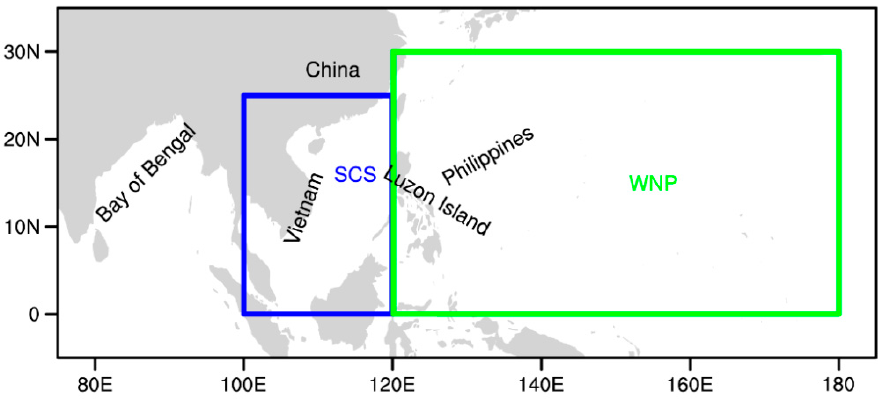
Figure 1. The locations of the Bay of Bengal, Vietnam, China, the South China Sea (SCS), Luzon Island, Philippines and the Western North Pacific (WNP). Blue box, the SCS area; green box, the WNP area.